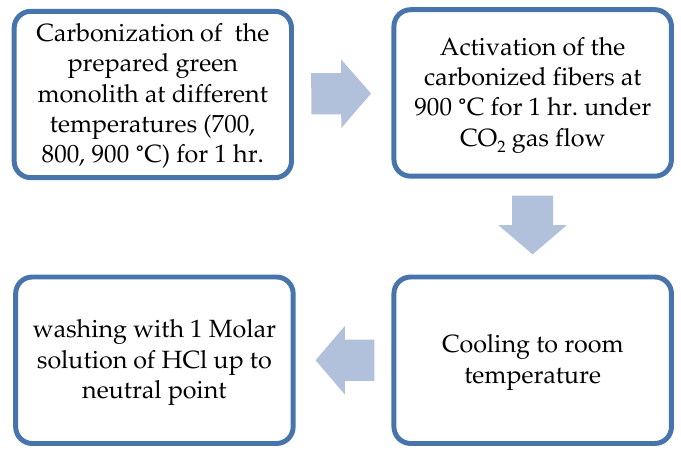
Figure 3. Steps of physical activation of the composite green monolith.